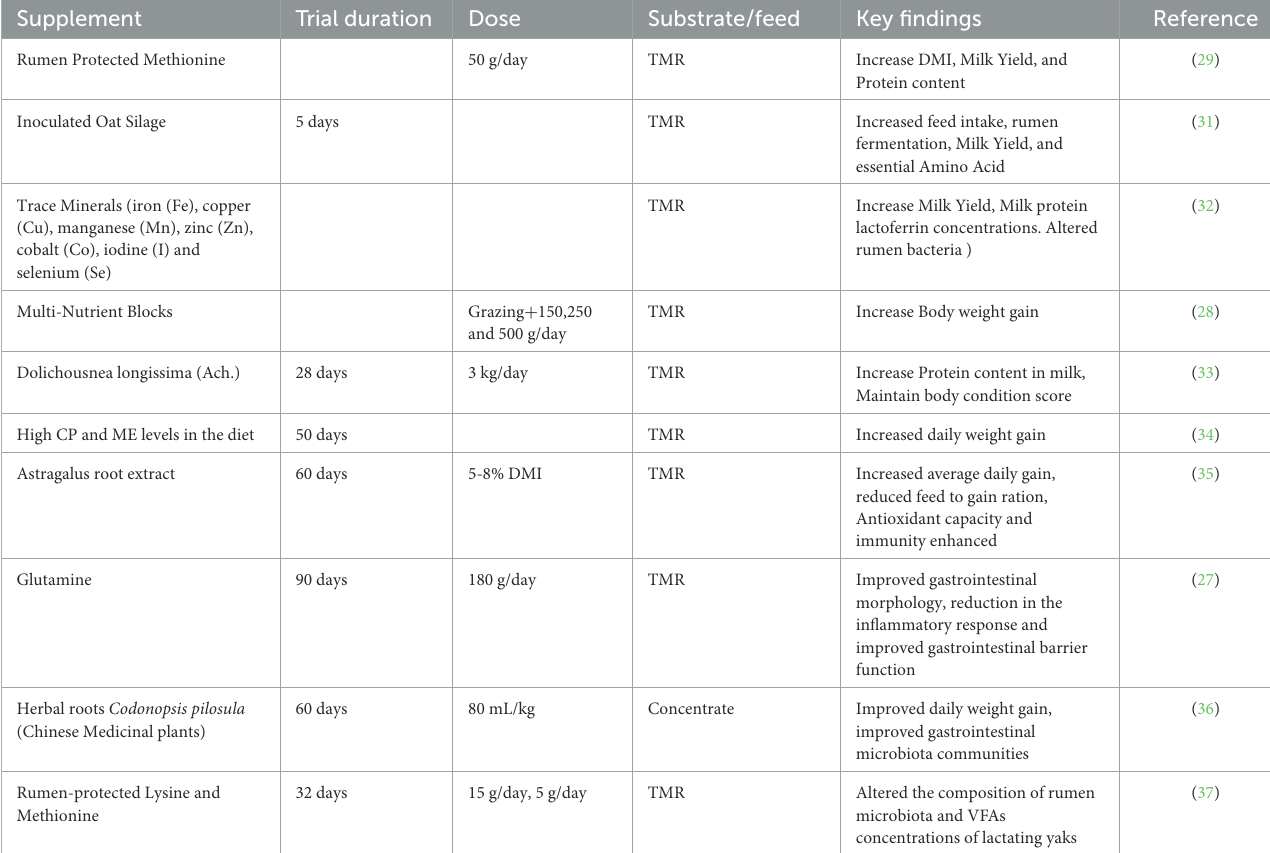
TABLE 1 Effects of different feed supplements on the growth and production performance of